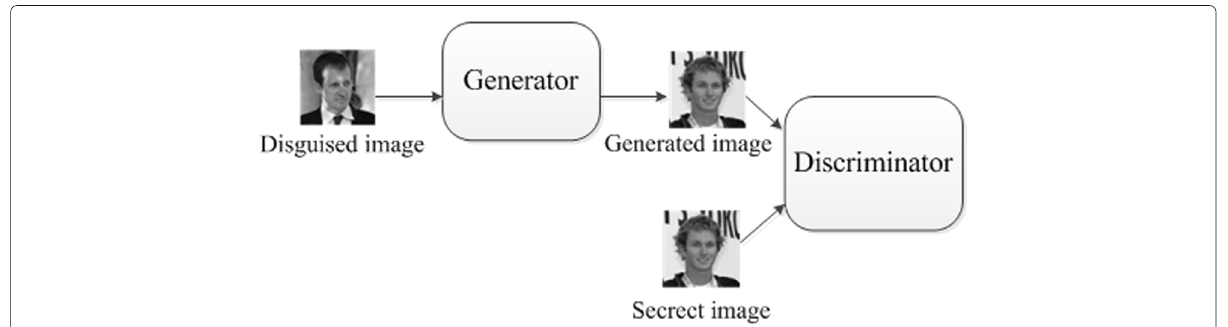
Fig. 3 The WGAN-GP model used in this paper